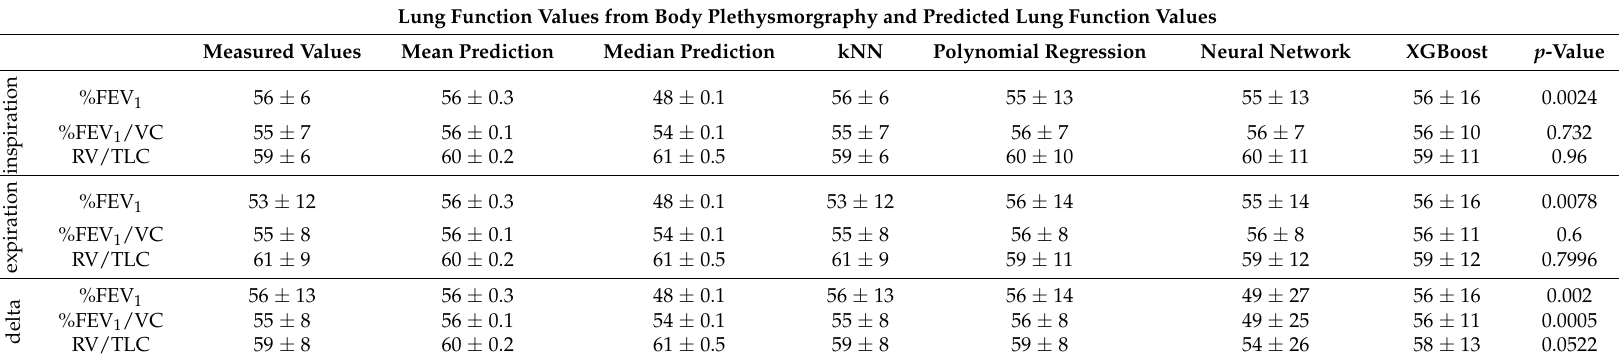
Table 2. Lung function values from body plethysmography and the predicted lung function values from all algorithms used with their standard deviation. Lung Function Values from Body Plethysmorgraphy and Predicted Lung Function Values Measured Values Mean Prediction Median Prediction kNN Polynomial Regression Neural Network XGBoost p -Value